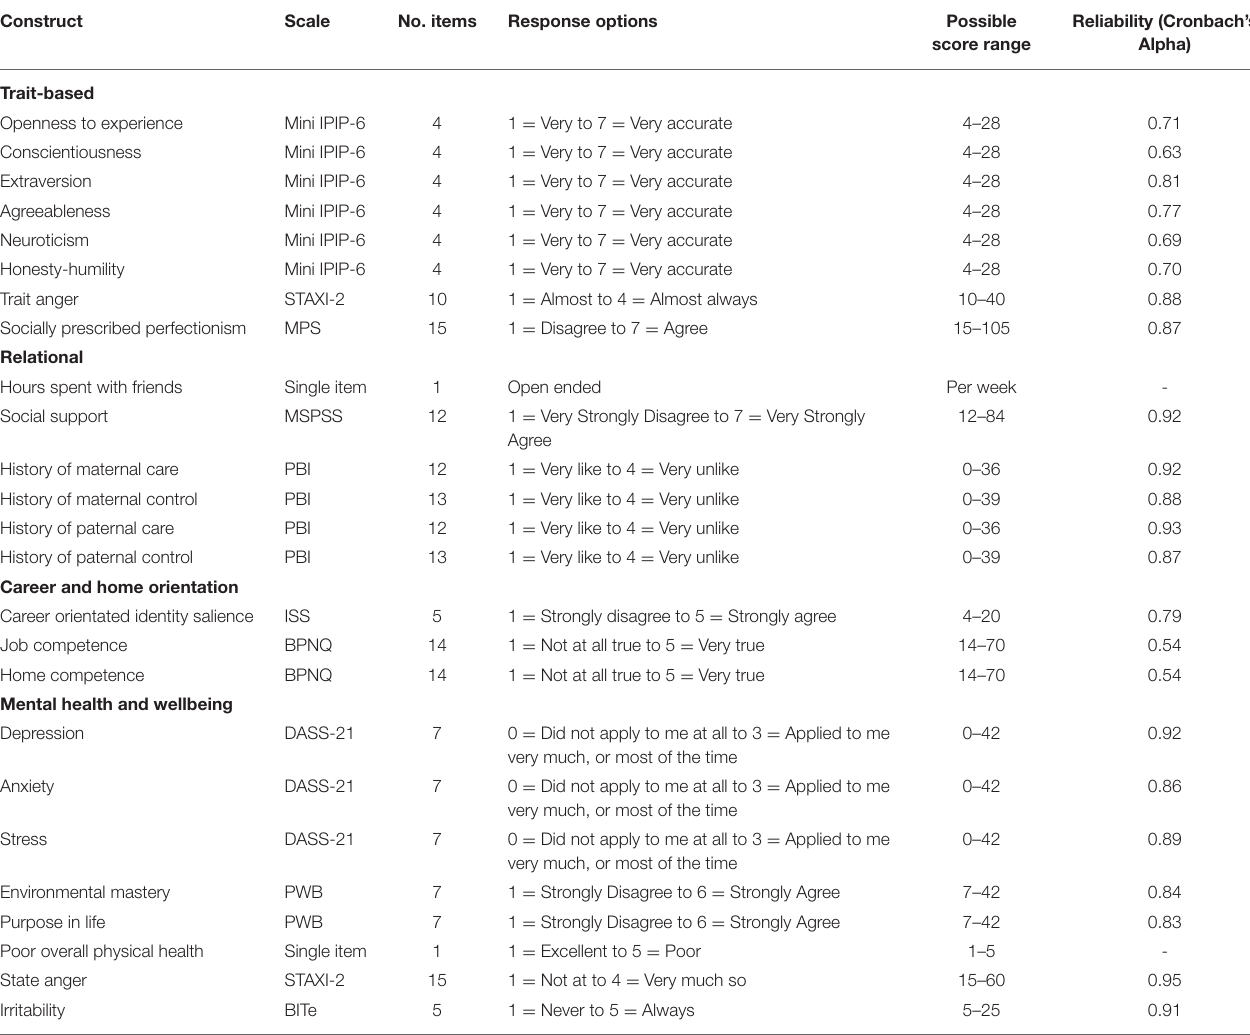
TABLE 1 | Pre-pandemic predictor